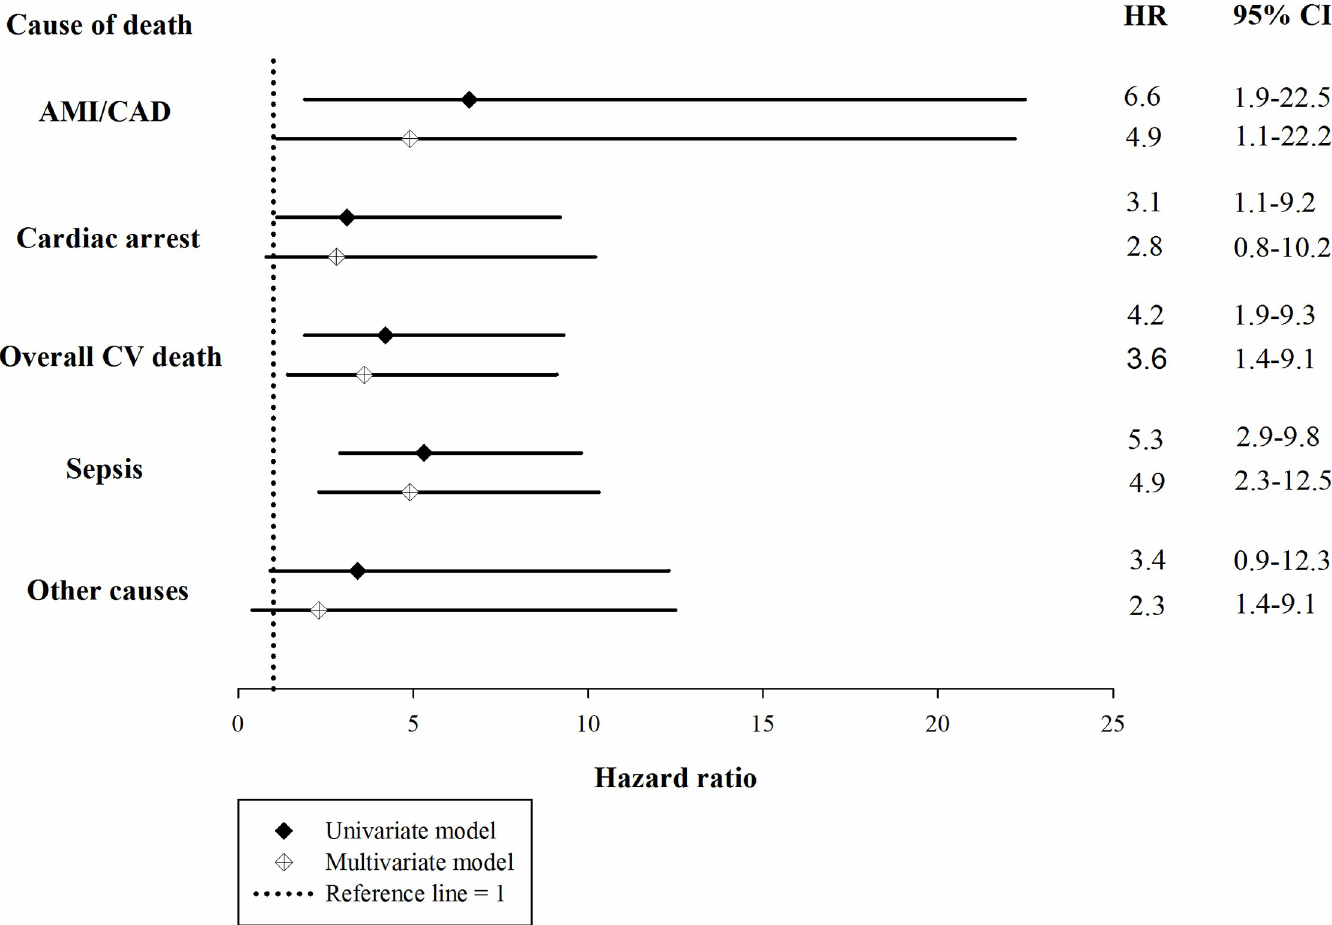
Fig 4. HR of AF for cause-specific mortality of incident ESRD patients on maintenance hemodialysis. Multivariate model was adjusted for age, presence of heart failure, chronic obstructive pulmonary disease, serum levels of C-reactive protein, albumin and phosphorus. HR, hazard ratio; CI, confidence interval; AF, atrial fibrillation; AMI, acute myocardial infarction; CAD, coronary artery disease; CV, cardiovascular.